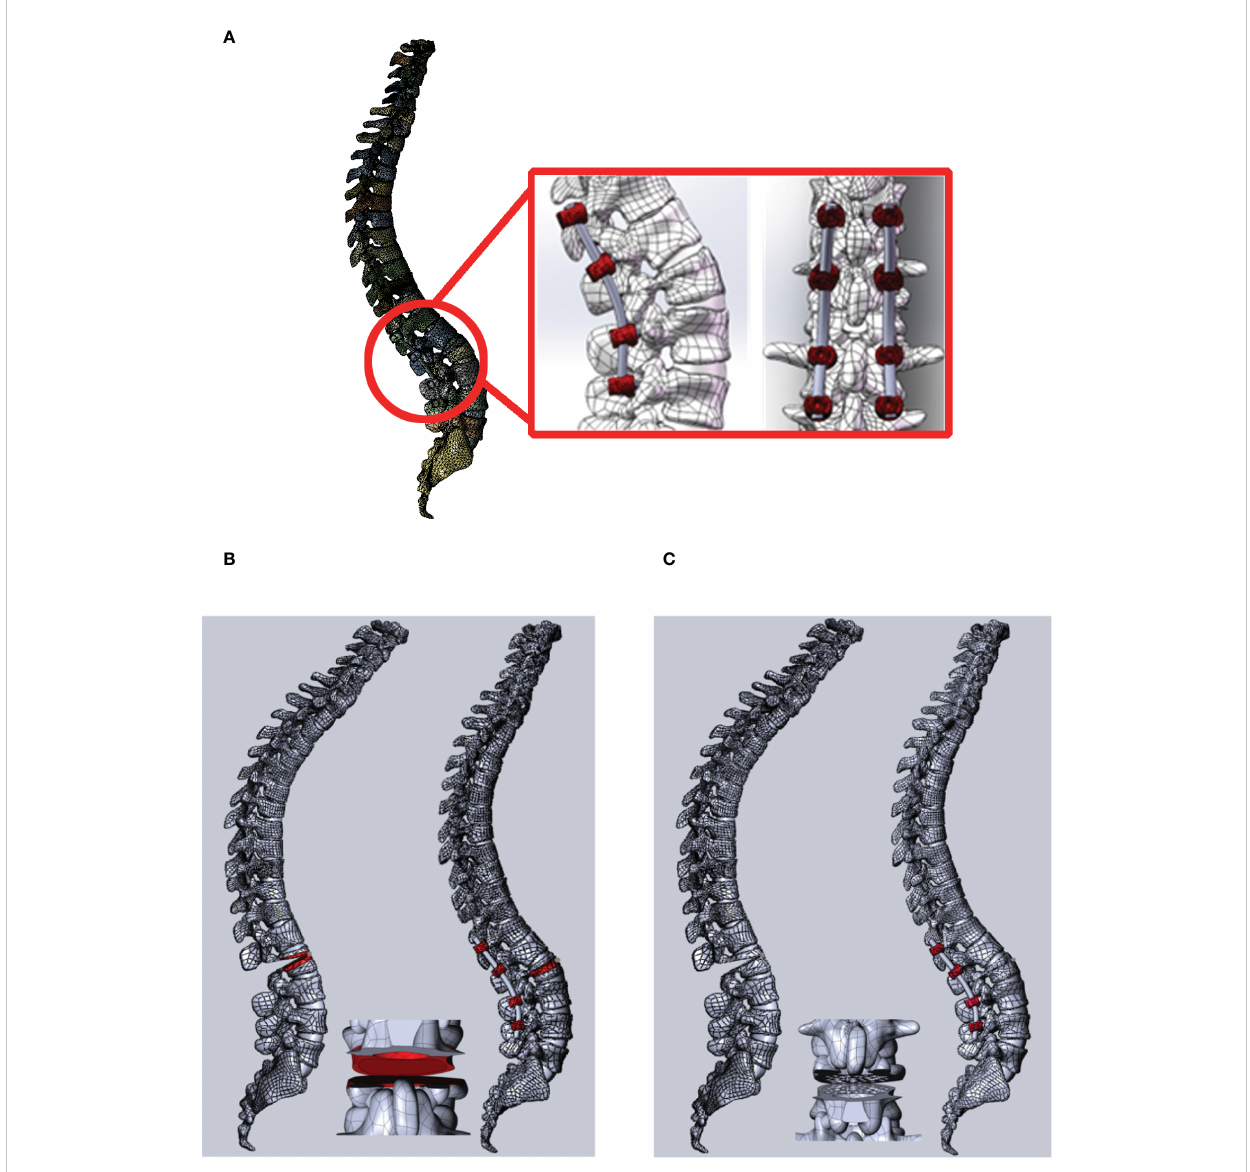
FIGURE 2 The PSO operation FEA model on the AS kyphosis model with VBCO and eggshell osteotomy. (A) The view of PSO operation on L2 with intra- pedicular screw fi xation from T12 to L4. The red box shows the local detailed structure of intra-pedicular screw fi xation and the osteotomy plane. (B, C) PSO operation with eggshell osteotomy (model 1, B ) and VBCO (model 2, C ) on the FEA